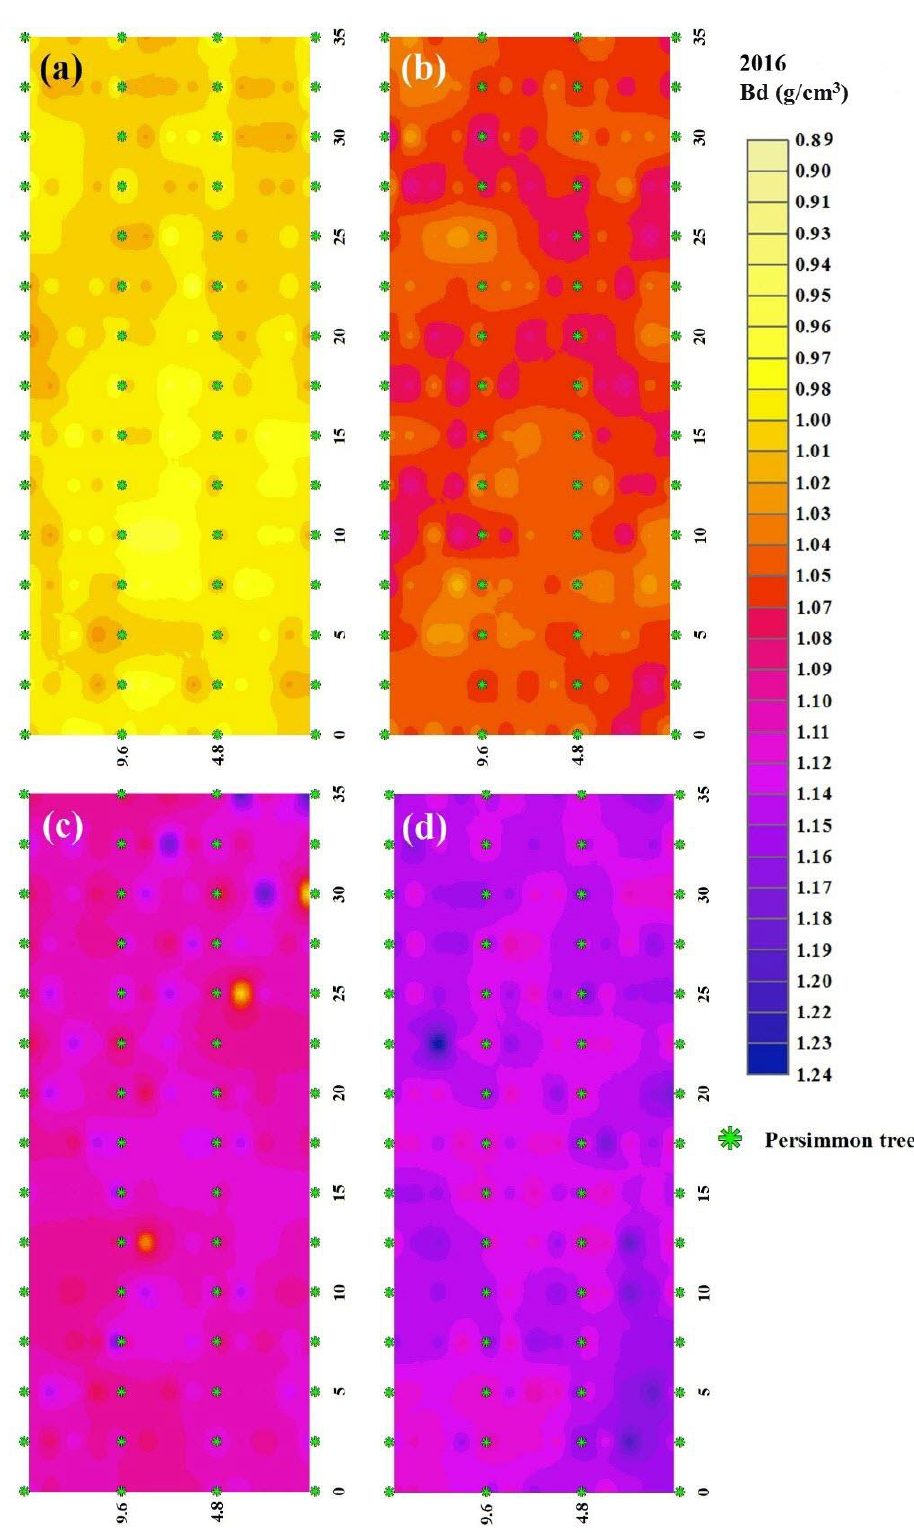
Figure 4. Spatial distribution of Bd at four depths: ( a ) 0–6 cm, ( b ) 6–12 cm, ( c ) 12–18 cm and ( d ) 18–24 cm in 2016.